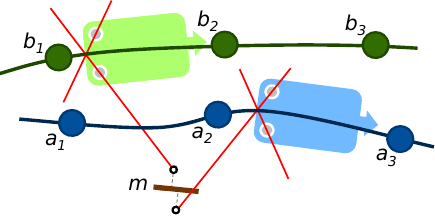
Figure 3. Geometric situation for the example of two scan strips. Blue and green curves are trajectories of the mapping van, red lines are scan rays, a i and b i are anchor points (where corrections for the exterior orientation are estimated), and m is one single surface element, where scan points are assumed to align.